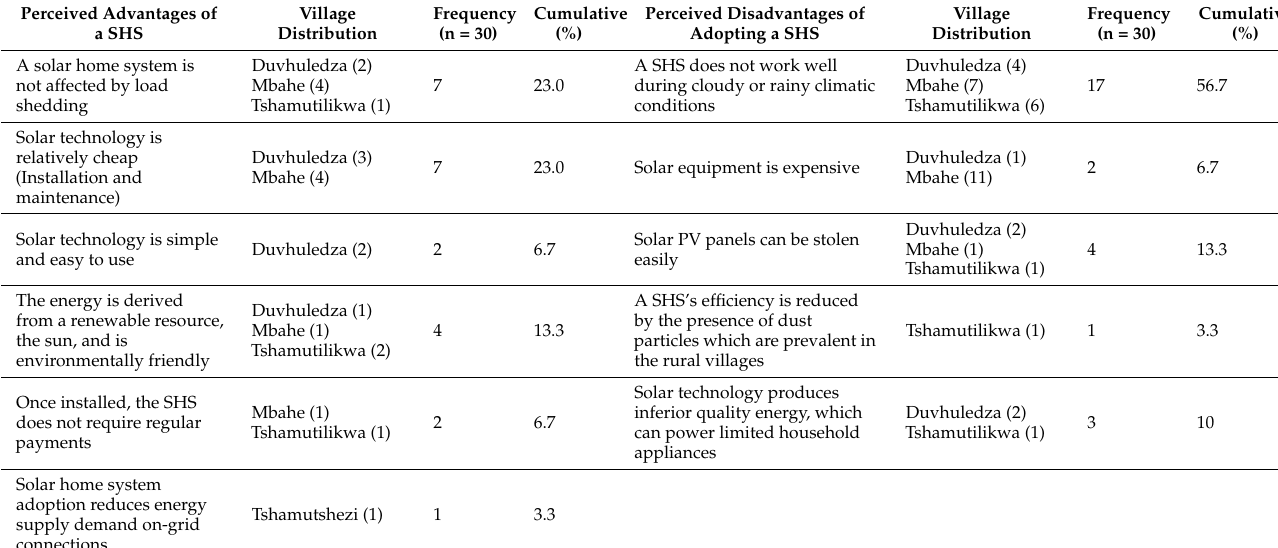
Table 3. Rural households’ perceptions of solar home systems